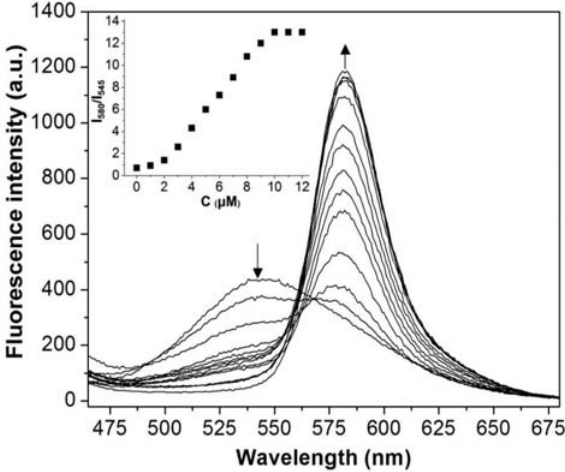
Figure 2. Fluorescence titration spectra of RD (10 μM) with Hg 2+ (0–12 μM). Inset: the fluorescent intensity ratio (I tion of Hg 2+